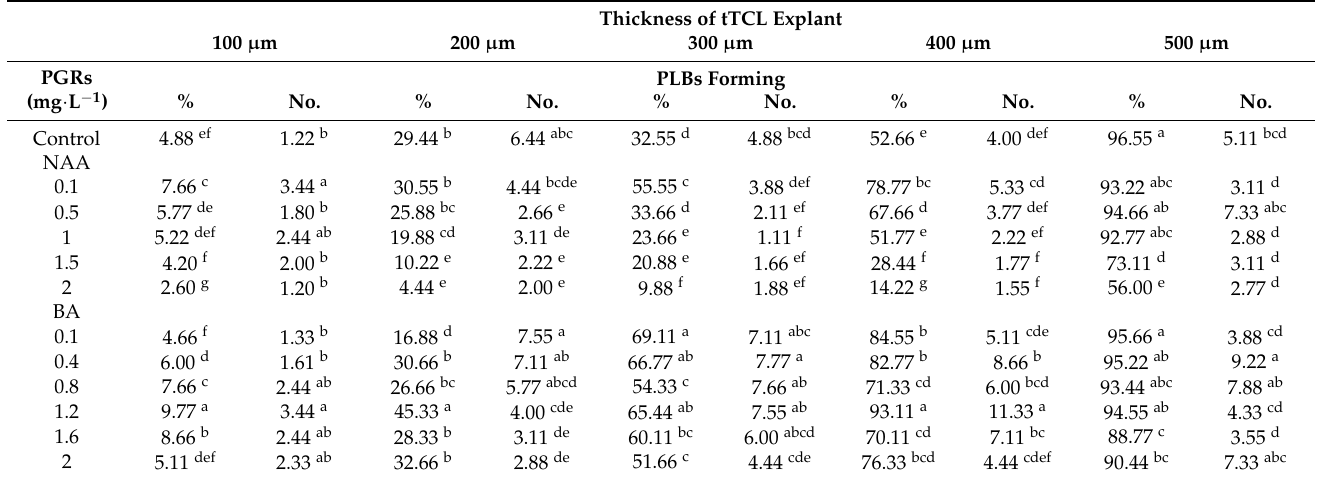
Table 2. Effect of PGRs and tTCL thickness on induction percentage and number of PLBs per explant in MS medium as observed after 45